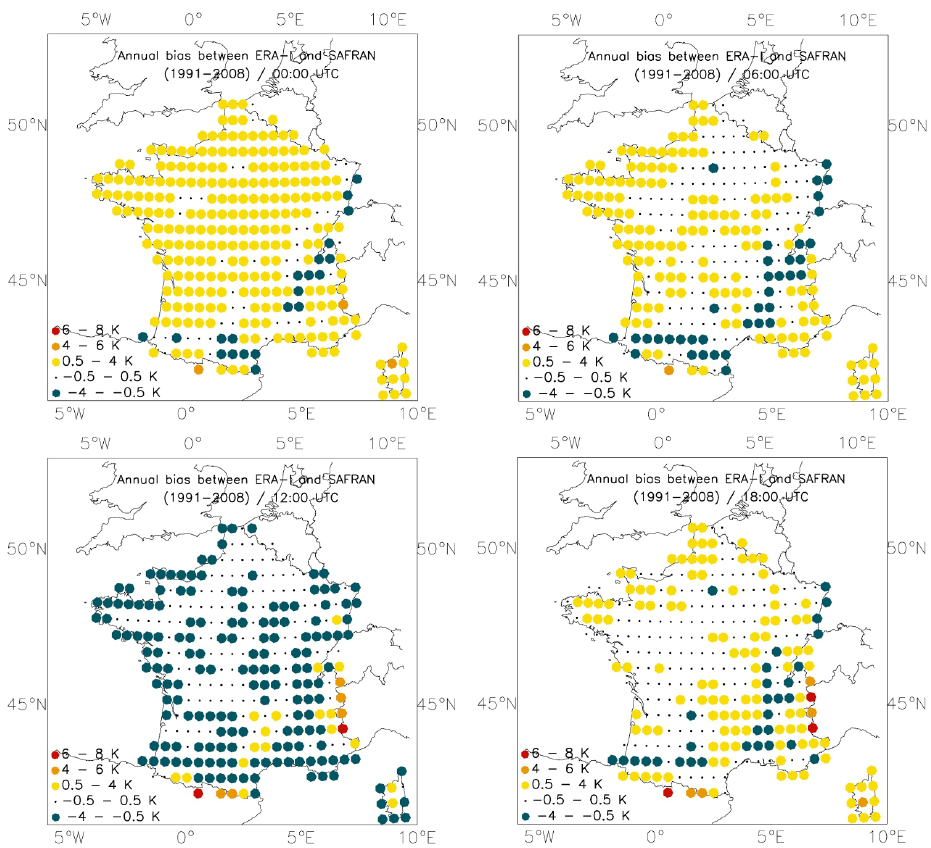
Fig. 10. Daily T a estimates over the period 1991–2008: ERA-I vs. SAFRAN in terms of mean bias, at (top and left) 00:00, (top and right) 06:00, (bottom and left) 12:00 and (bottom and right) 18:00UTC. Table 6. Performance of ERA-I for the SMOSREX site: mean bias (ERA-I minus SAFRAN), RMSE and square correlation coefficient